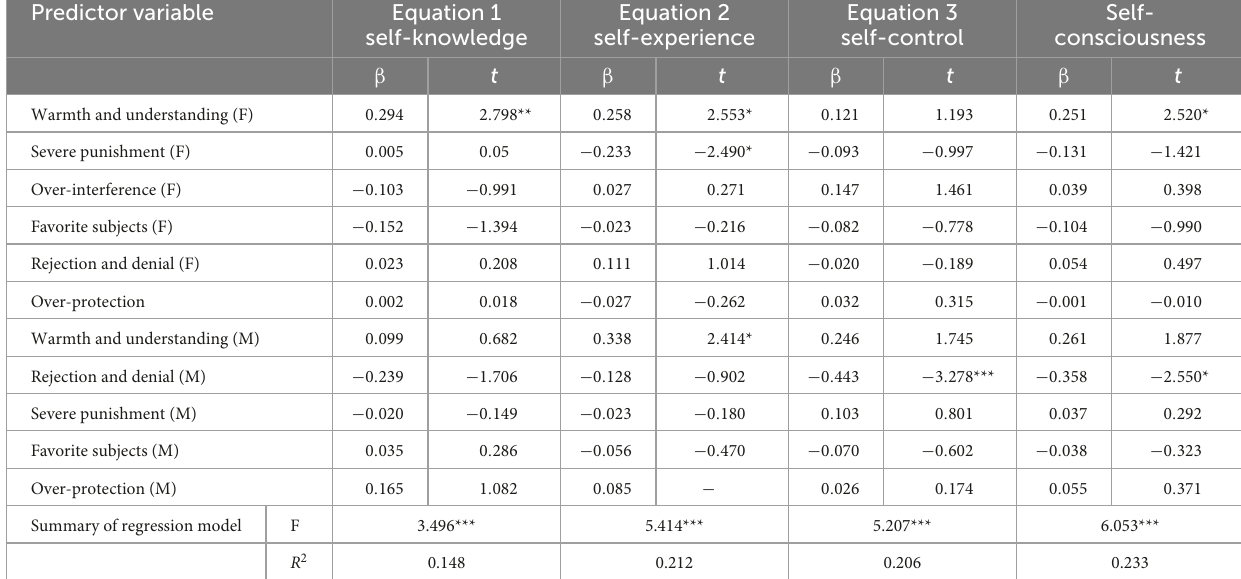
TABLE 1 Summary table of multiple regression analysis of each dimension of juvenile delinquency’s parenting style to each dimension of self- consciousness. Predictor variable Equation 1 self-knowledge